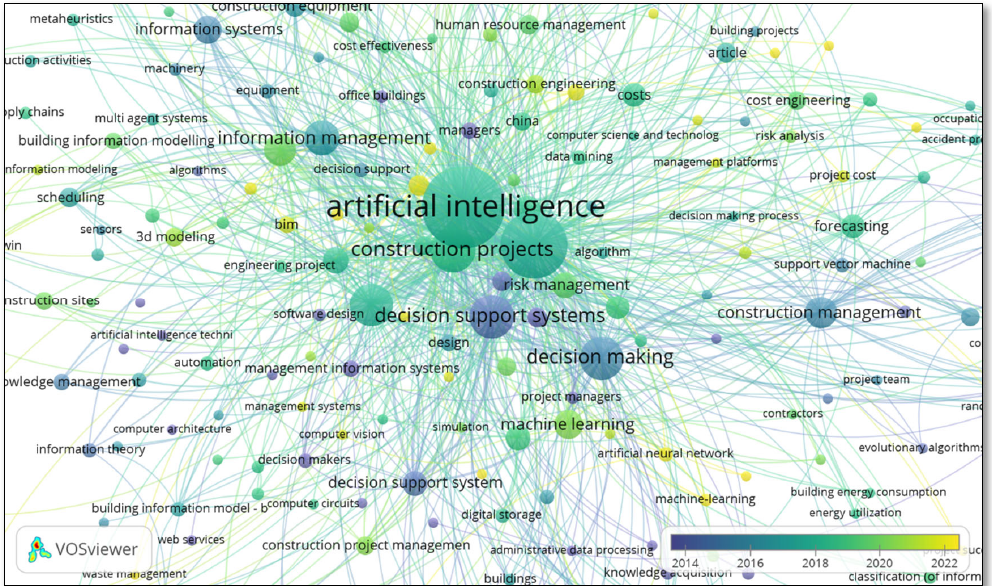
Fig. 2. Bibliometric map of the analysis of the words “Artificial Intelligence”, “project management” of “construction”, with greater interaction Source: Obtained from the VOSviewer analysis.